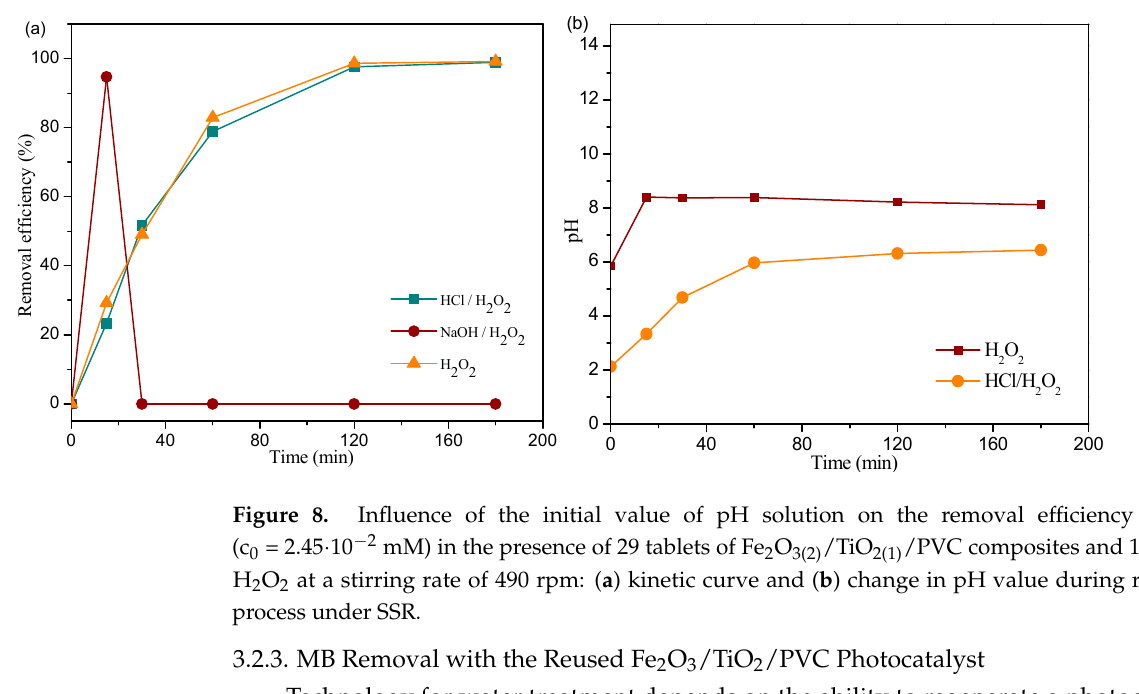
3.2.3. MB Removal with the Reused Fe 2 O 3 /TiO 2 /PVC Phot о catalyst